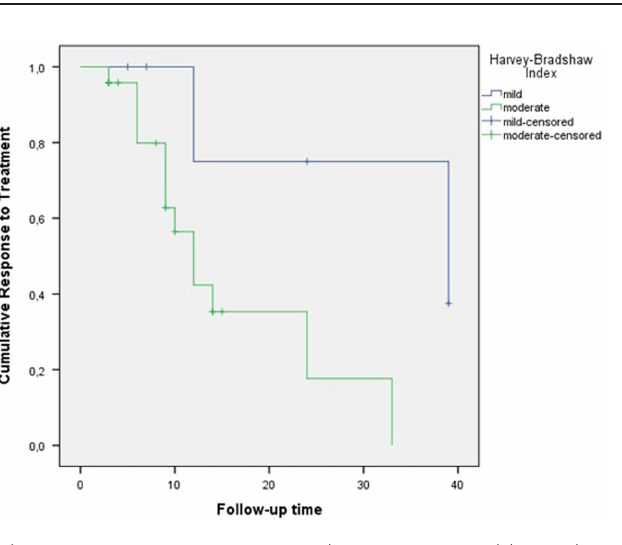
Figure 1. Treatment response according to Harvey–Bradshaw Index in patients with Crohn’s disease.